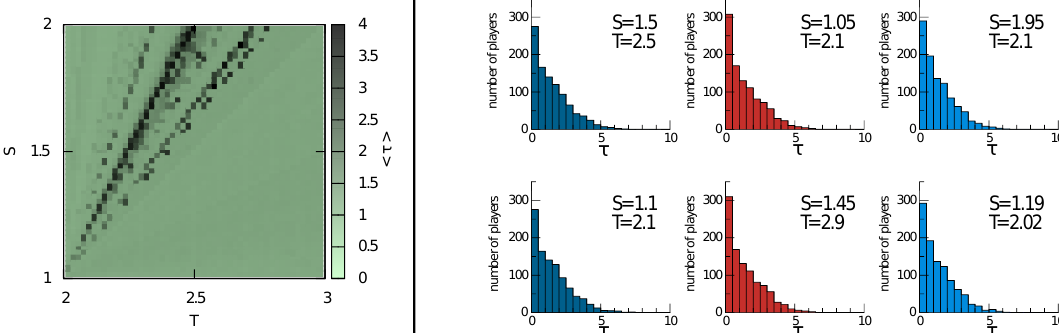
Figure 6. Dynamics of the SG game in Scenario A. The leftmost panel shows in color code the average (cid:104) τ (cid:105) of the Poisson parameter of the population in the stationary state; while the panels on the right show the histograms of τ for a few selected points, with figures in the same vertical corresponding to games in the same equivalence class m . The values of the game parameters T and S are shown inside the corresponding